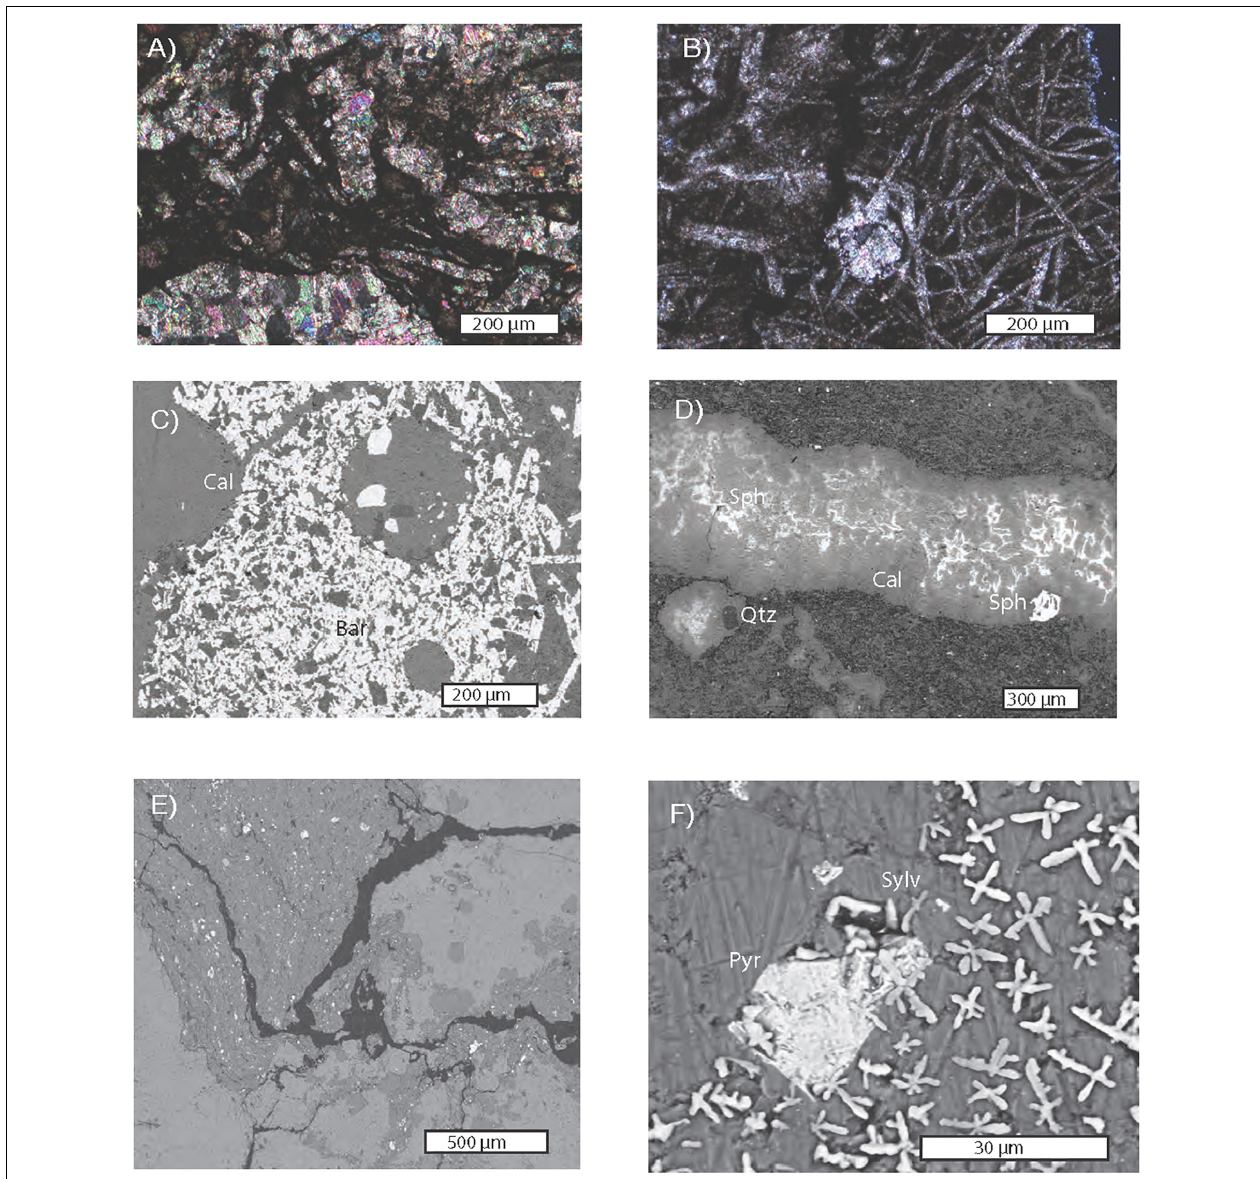
FIGURE 2 | Photomicrographs from the diagenetically altered breccia facies in both cores. (A) Diagenetically altered and veined breccia in EC. Veins are composed of calcite with minor barite. (B) Cross-polarized thin section photomicrograph containing fibrous barite, and a recrystallized algal cyst in EC. In the recrystallized algal cyst, there is a barite cement, followed by a rim of clays and bitumen, and then more barite. Note stylolite cutting the barite. (C) Backscatter SEM image of barite in the EC (Bar: Barite; Cal; Calcite). (D) Backscatter SEM image of sphalerite (Sph) in calcite veins from the diagenetically altered breccia in EC. The sphalerite is found as crystals within the calcite (Cal) veins and as a milky texture throughout the veins (Qtz; Quartz). (E) Backscatter SEM image of the breccia in EC which shows shale displaying flow patterns. (F) Backscatter SEM image of sylvite (Sylv) and pyrite (cubic, Pyr) within the diagenetically altered breccia in